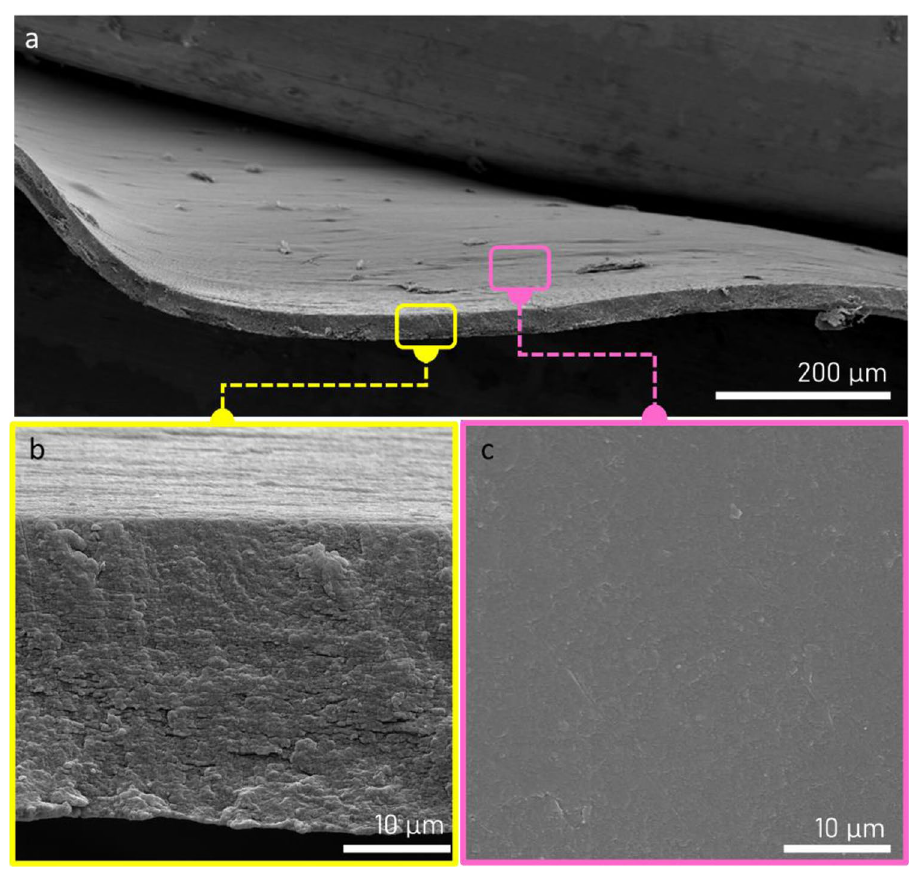
Figure 2. Scanning electron microscopy images showing ( a ) an overview, ( b ) the cross-section, and ( c ) the surface of prepared chitin–ethylene glycol thin